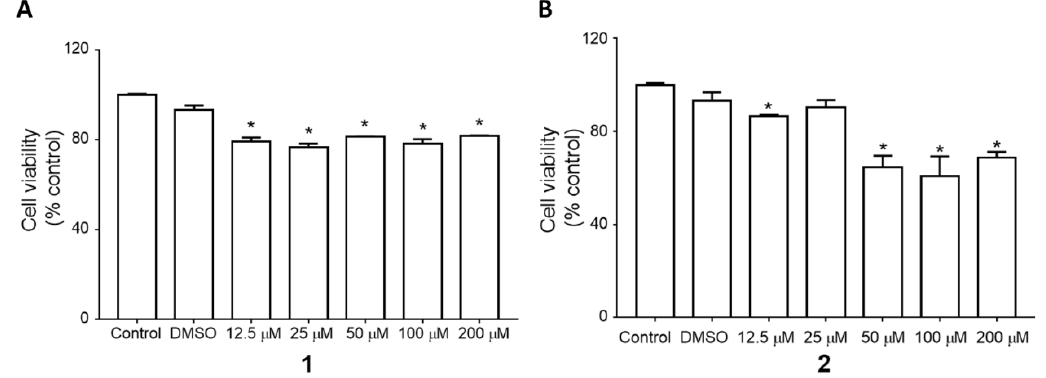
Figure 2. Cytotoxicity of compounds 1 and 2 . Cell viability was examined in 3T3-L1 preadipocytes treated with various doses (12.5–200 µ M) of compounds 1 ( A ) and 2 ( B ) for 24 h. The values are the means ± SEM of three experiments. * p < 0.05 vs. control (no treatment).